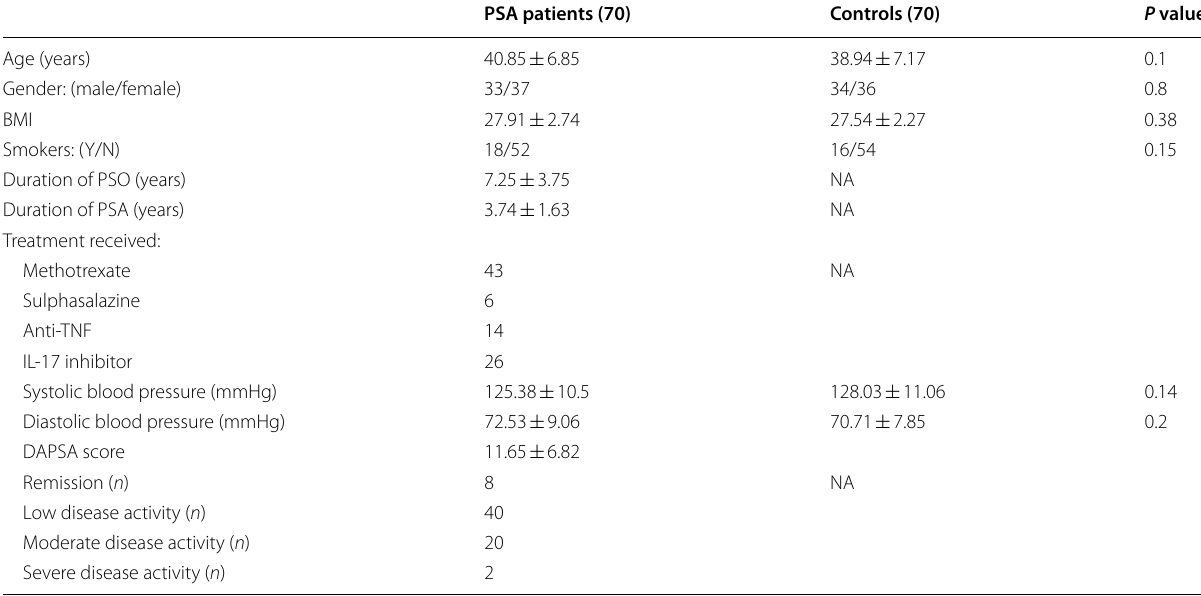
PSA psoriatic arthritis, Anti-TNF anti-tumor necrosis factor, IL-17 interleukin-17, DAPSA Disease Activity index for Psoriatic Arthritis, BMI body mass index